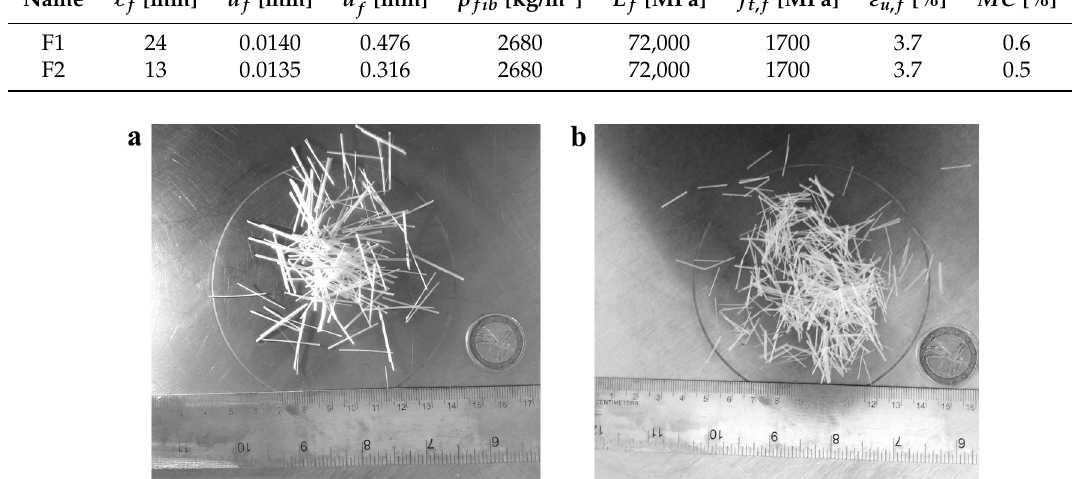
Figure 1. Two fiber types used in the experimental campaign: the F1 ( a ) and the F2 ( b